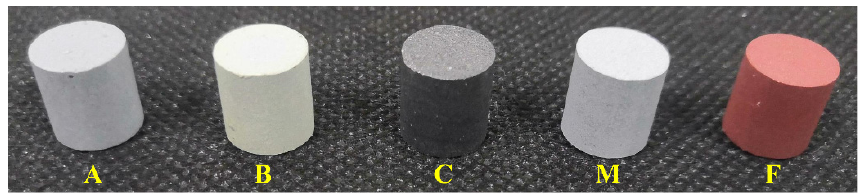
Figure 1. Morphology of PTFE/Al/oxides: A, B, C, M, and F are PTFE/Al, PTFE/Al/Bi 2 O 3 , PTFE/Al/ CuO, PTFE/Al/ MoO 3 , and PTFE/Al/ Fe 2 O 3 , respectively.